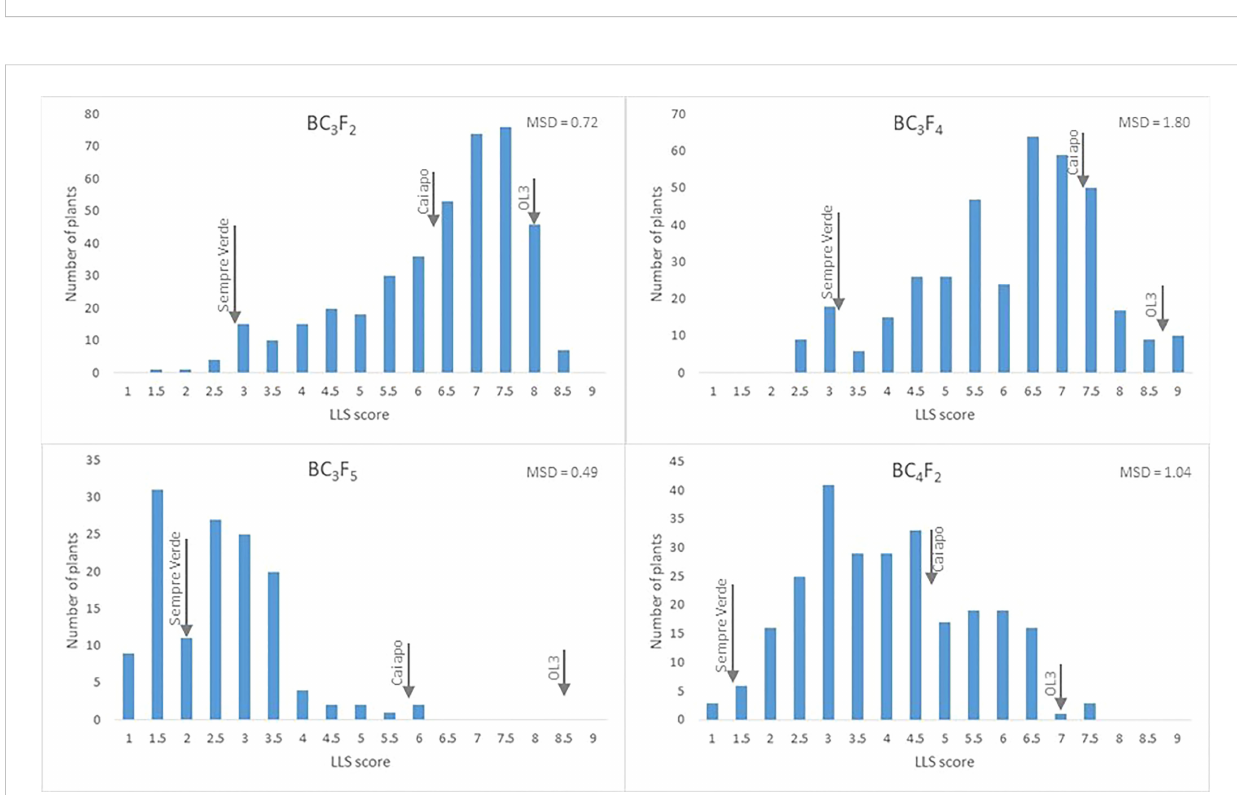
FIGURE 3 Frequency distribution of LLS resistance in four populations derived from 'IAC OL 4' × MagSten crosses. ‘ IAC Sempre Verde ’ (resistant), ‘ IAC Caiapo ́ ’ (partly resistant), and ‘ IAC OL 3 ’ (susceptible) were used as controls, and their average scores were indicated by arrows. MSD is the minimum signi fi cant difference estimated by the Tukey test at 5%